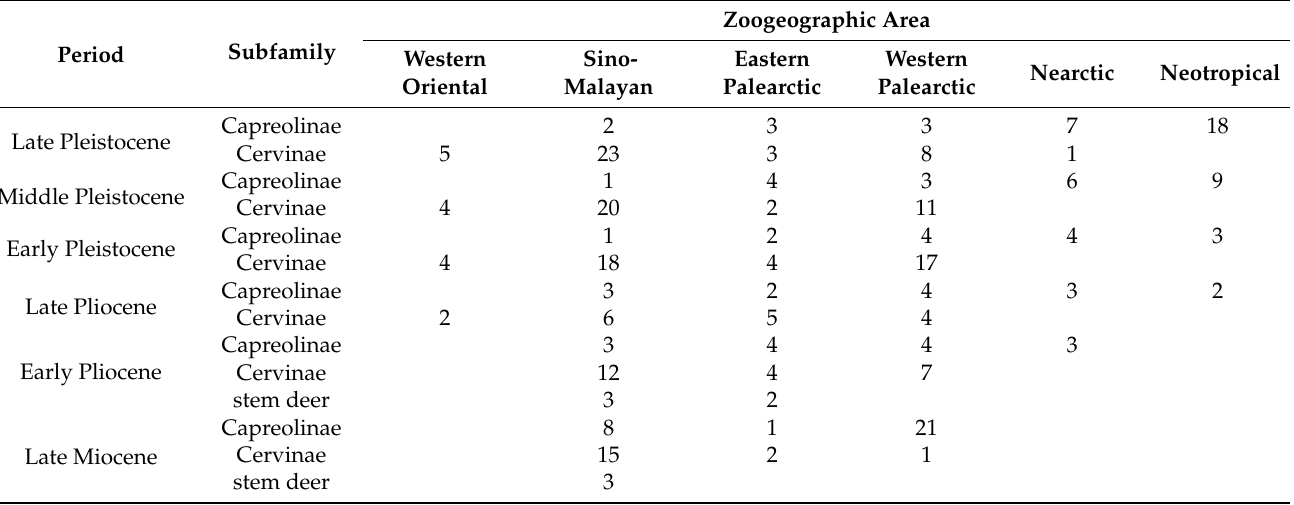
Table 1. Number of recognised crown deer species of the world from the late Miocene to the late Pleistocene of the considered zoogeographic